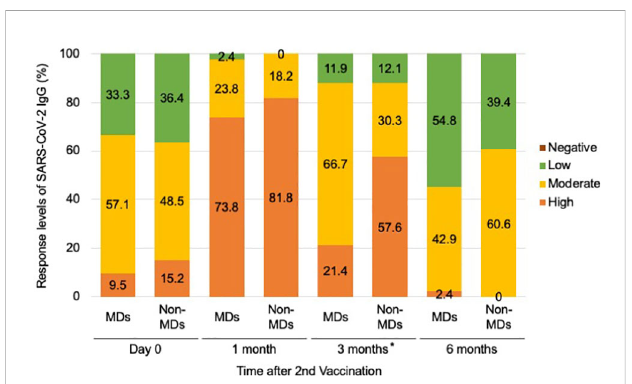
FIGURE 3 Serological response levels of anti-SARS-CoV-2 IgG antibody after second vaccination in the muscular disorders (MDs) group (n = 42) and non-MDs group (n = 33). Categorical levels of antibody responsiveness based on anti-SARS-CoV-2 IgG antibody quantitative titers that were provided by the manufacturer (Abbott, Chicago, USA) were de fi ned as follows; Negative (<7.1 BAU/mL), Low positive (7.1 – 119.2 BAU/mL), Moderate positive (119.3 – 567.9 BAU/mL), and High positive (>568 BAU/mL). Comparing the incidence of immune responses, a signi fi cant difference was observed between MD and non-MD groups at 3 months following the second vaccination. * indicates p -value less than